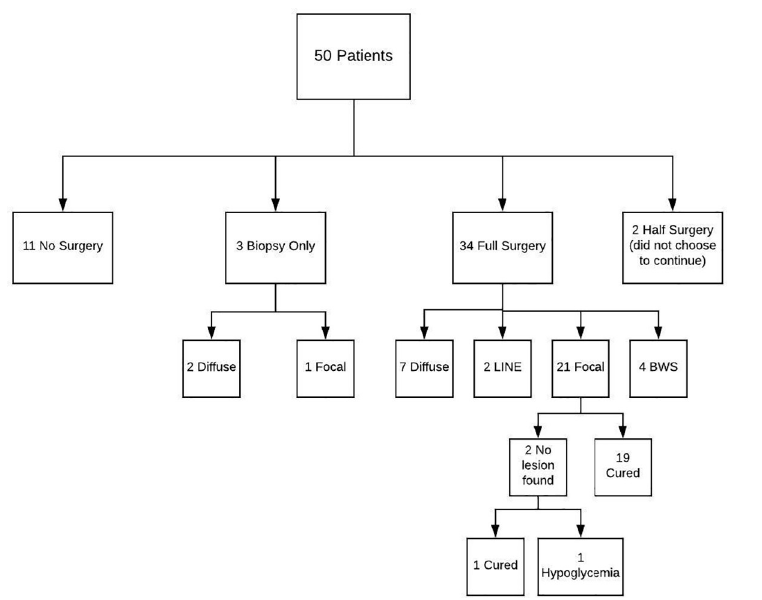
Fig 1. Flowchart of 50 subjects.